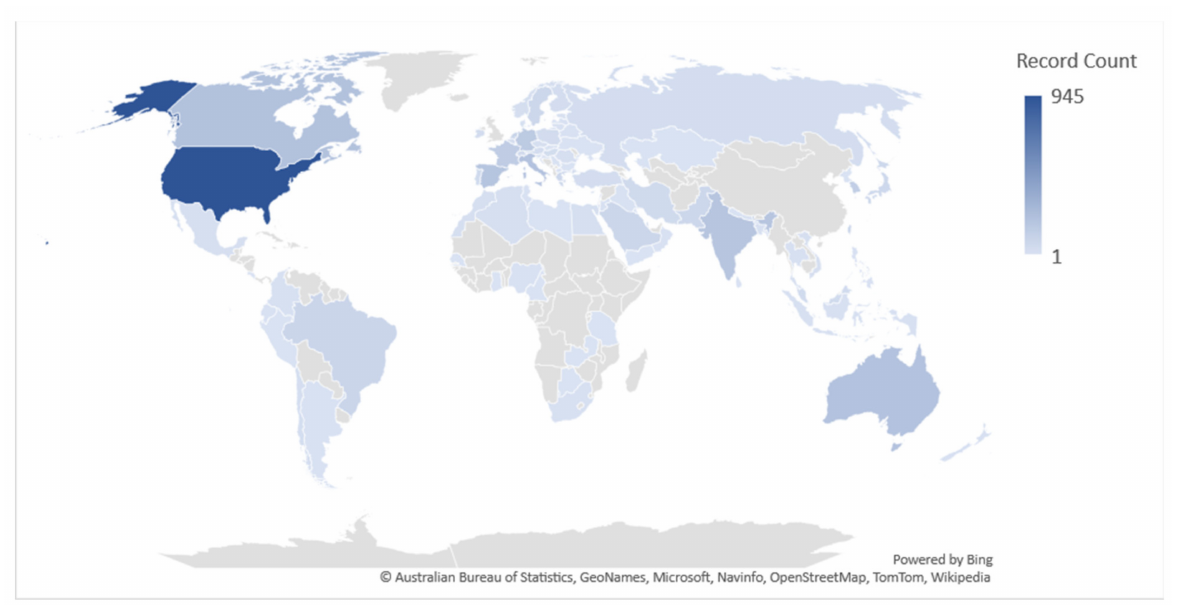
Figure 2. Mapping publication outputs by countries. Illustration by Authors.